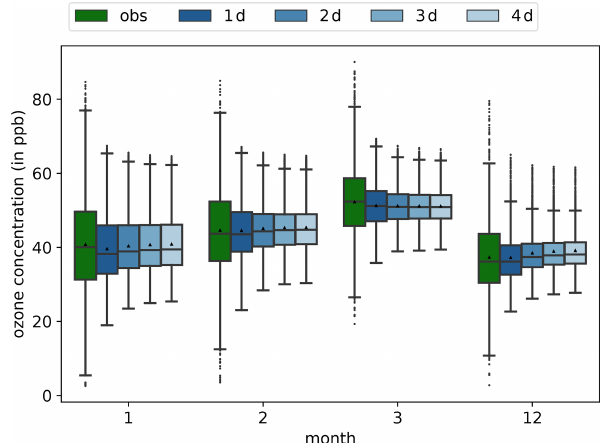
Figure 6. Monthly dma8eu ozone concentration for all test pseudo- stations as box plots. Pseudo-observations are denoted by obs (green), and forecasts are denoted by 1d (dark blue) to 4d (light blue). Triangles display the arithmetic means.